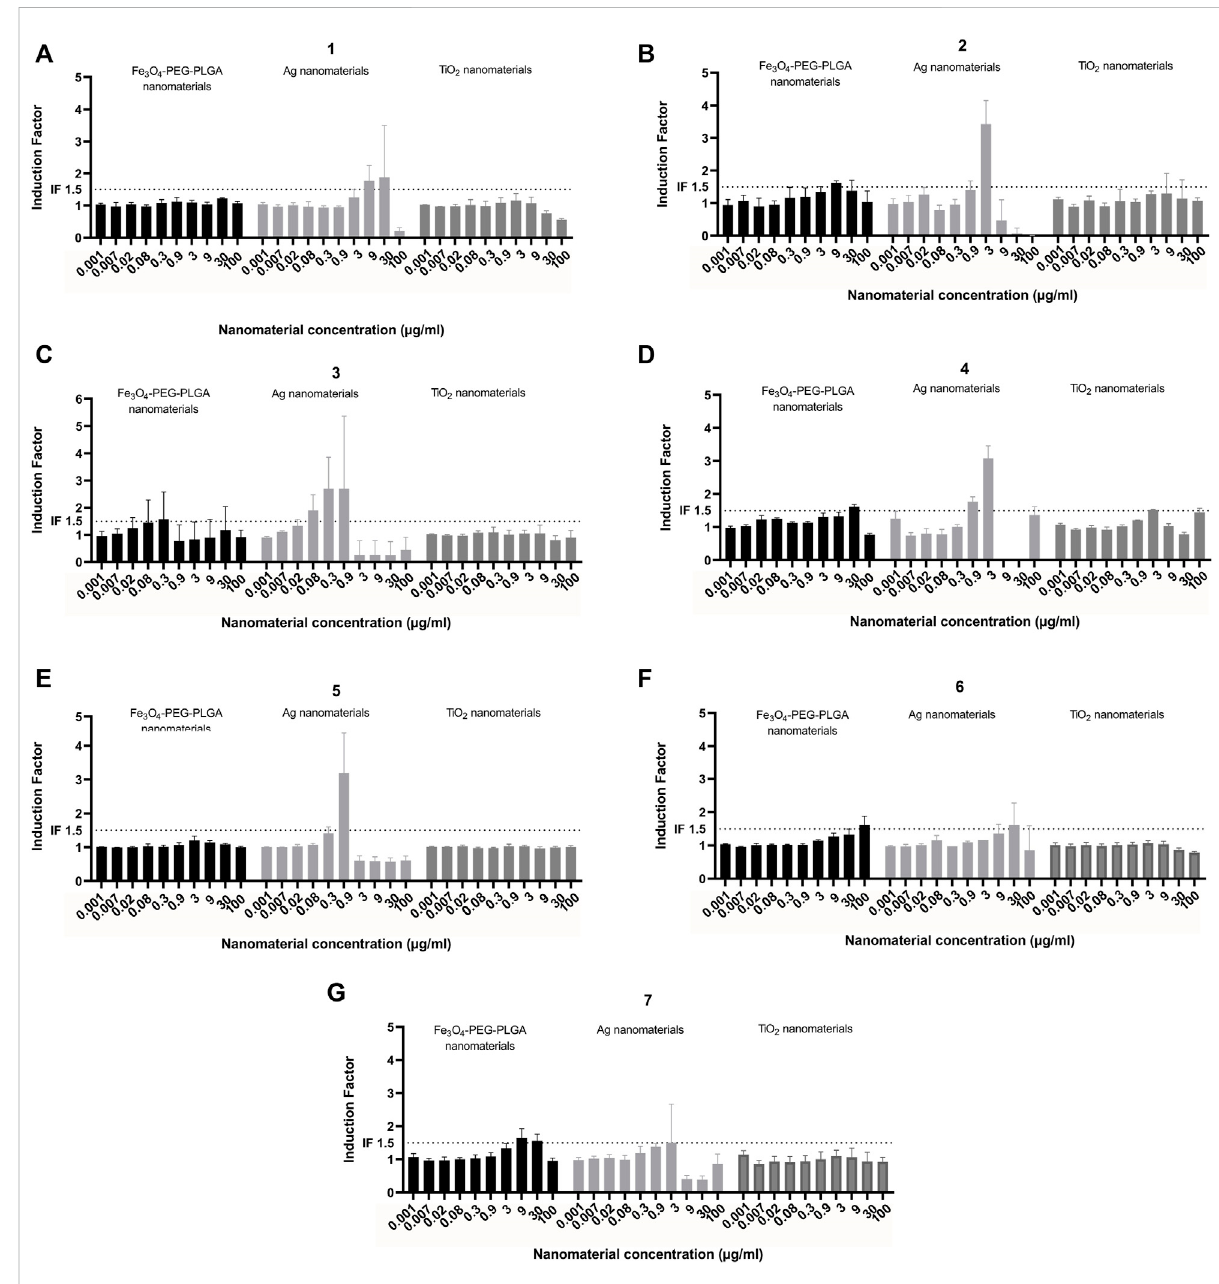
FIGURE 6 Interlaboratory study. Induction of NRF2 mediated gene expression following exposure of Fe 3 O 4 -PEG-PLGA, Ag nanomaterials and TiO 2 nanomaterials. Each graph (A – G) represents the results of an individual laboratory. Each experiment was performed according to the same harmonized protocol. The results are presented as induction factor, the fold induction over the solvent control. The data are presented as mean values ± S.D. of three independent experiment. The numbers represent the individual participating laboratories. Black bars: Fe 3 O 4 -PEG-PLGA, light grey bars: Ag; dark grey bars: TiO 2